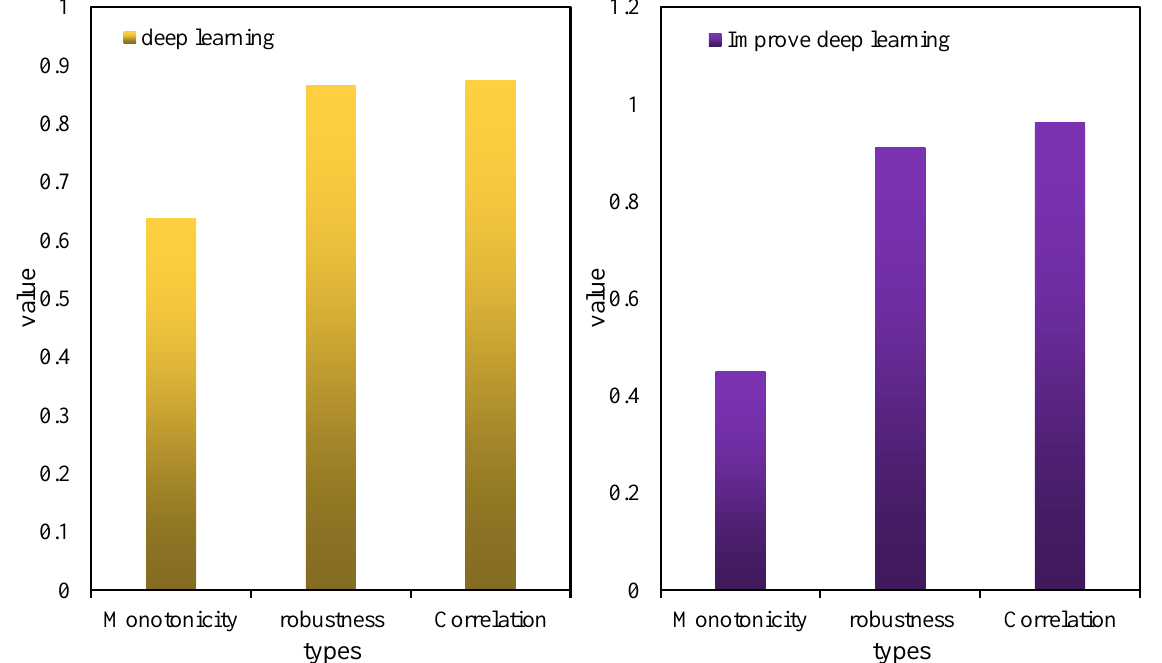
Figure 8. Results of health index evaluation constructed by two methods.